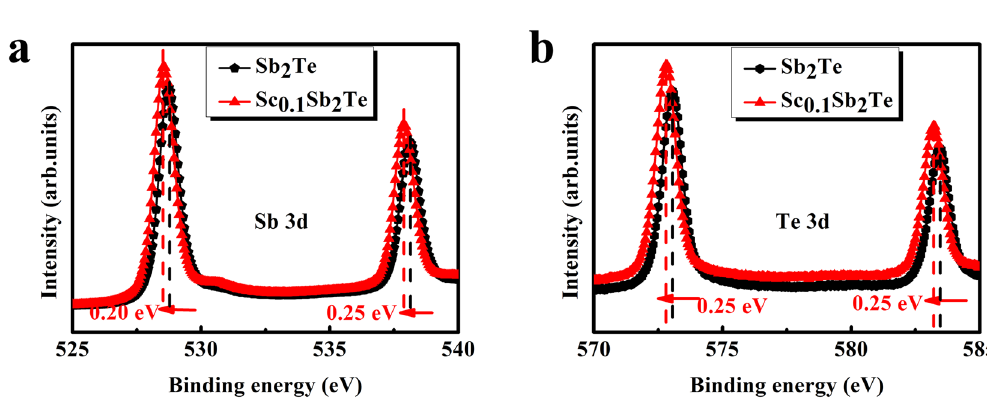
Figure 3. XPS spectra for annealed Sb 2 Te and Sc 0.1 Sb 2 Te films: ( a ) Sb 3d, and ( b ) Te